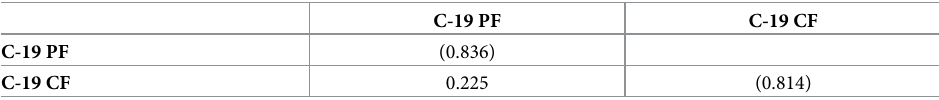
Note: The elements on the diagonal values in parentheses represent the square root of the variance extracted (AVE) and the values outside the diagonal represent the correlations between the